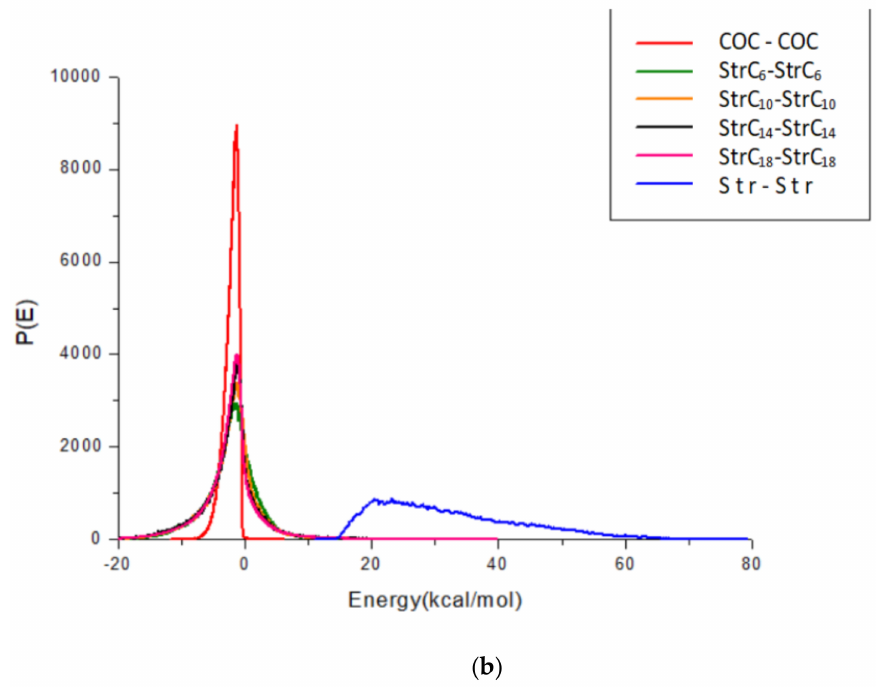
Figure 7. The binding energy distributions curves of ( a ) water and ( b ) ceramide, cholesterol and free fatty acid of equal molar ratios (COC) with Str and Str ion-pair